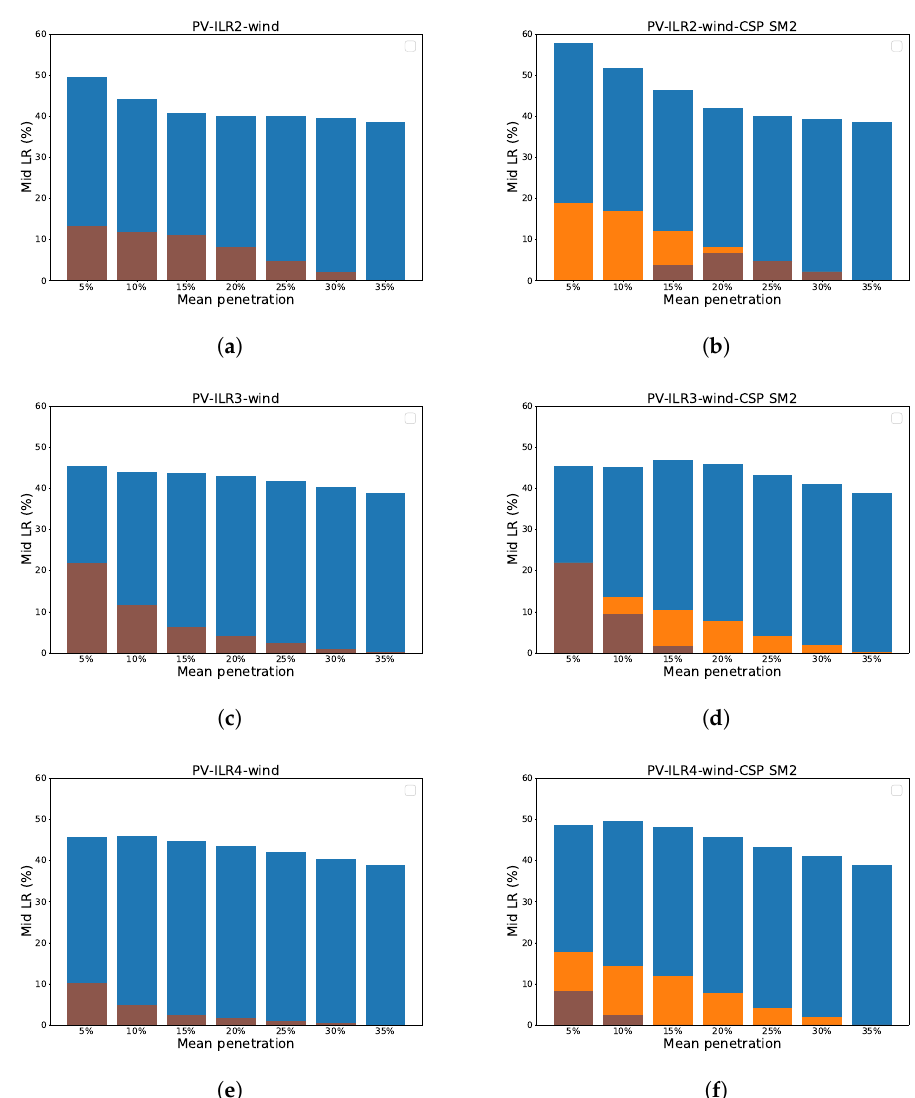
Figure 10. Mid load reduction by each technology—Wind (blue), PV-BES (brown) and CSP-TES (orange)—versus the mean penetration (1), µ , for the global strategy (2) with maximum-cost con- straint (5). ( Left ) PV-BES-wind mix; ( Right ) PV-BES-wind-CSP-TES SM2 mix. ( Top ) ILR2; ( Middle ) ILR3; ( Bottom )